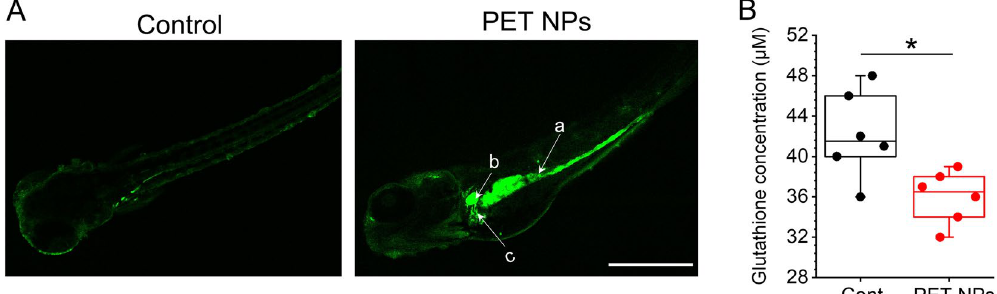
Figure 7. ( A ) Localization of reactive oxygen species (ROS) production in zebrafish embryos exposed to PET NPs (100 ppm) as compared to control embryos. Embryos (96 hpf which were already treated with PET for 24 h) were incubated for 60 min in CM-H2DCFA (10 μM) in rearing medium. Fluorescence detected in different regions of PET NPs treated embryos including (a) Intestine), (b) gall bladder and (c) liver. Scale bar: 1 mm. ( B ) Glutathione levels in extracts of zebrafish embryos (72 hpf) exposed to PET NPs (100 ppm for 24 h) as compared to control (Cont) embryos. Glutathione (GSH) levels were analysed by using GSH assay kit from Sigma-Aldrich. Significant reduction of GSH (* p < 0.05; n = 6) in PET NPs-treated embryo is clearly